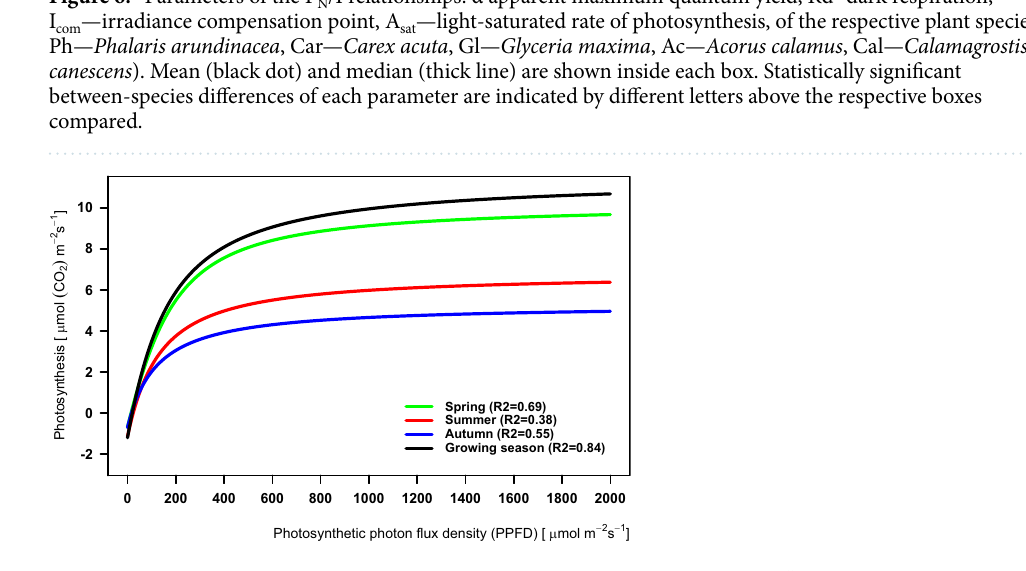
Figure 7. Average photosynthesis–irradiance relationship (P N /I) of the theoretical “ecosystem big-leaf” modelled by non-rectangular hyperbolas with real plant species composition. The P N /I relationships are presented separately for different periods: spring, summer and autumn. The P N /I relationship including the whole growing season is shown for comparison with those for individual growth periods. All curves were weighted by the plant species´ partial LAI values in individual growth periods (Fig.